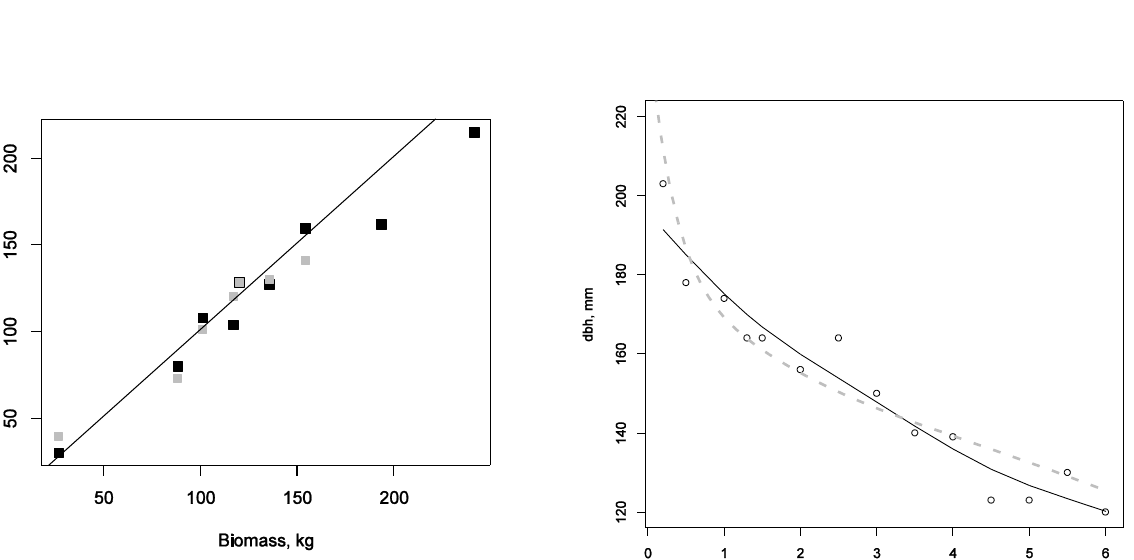
Figure 5. Field measured vs. predicted biomasses for pines. Predicted by models (Repola 2009, black) and TLS (grey) Then we tested linear regression models were we used TLS measured dbh , height and crown dimensions as predictors. In the fig.5 are plotted Repola (black) and TLS (grey) estimated biomasses for Scots pines. Correlation between the field measured and TLS predicted biomasses was 0.99 for Scots pines. In fig 6. respective plot for spruces is presented. Correlation between the field measured and TLS predicted biomasses was 0.98 for spruces.